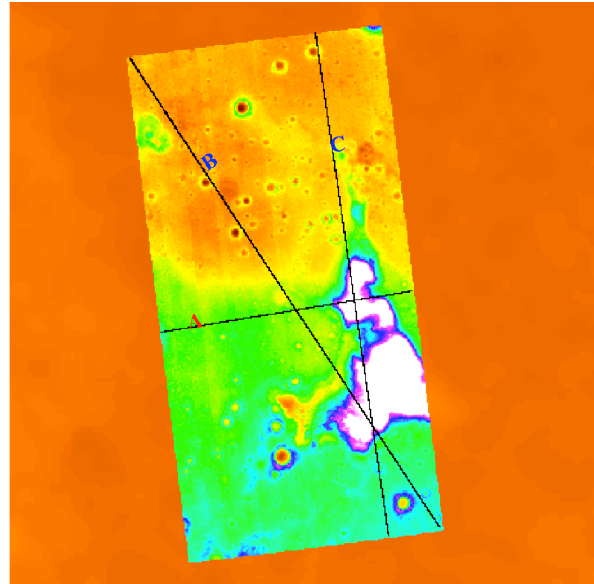
Figure 8 Example of co-registered MER-A HiRISE DTM on the top of HRSC DTM showing selected 3 profile lines A, B, and C